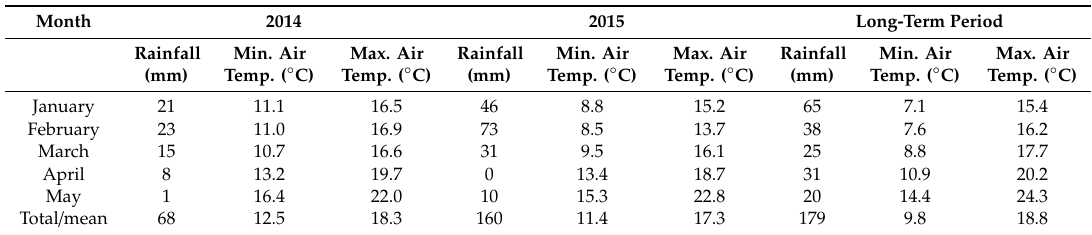
Table 1. Rainfall, mean minima and maxima temperatures during the ‘early’ potato growing season in the years of study as compared to the long-term period